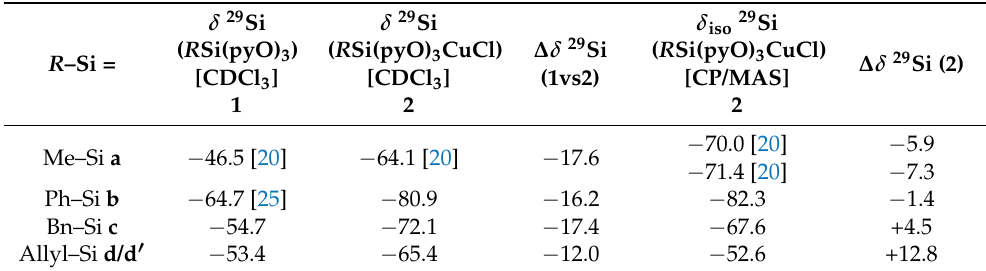
Table 2. 29 Si NMR shifts (in ppm relative to SiMe 4 ) of silanes 1a [20], 1b [25], 1c , 1d and of